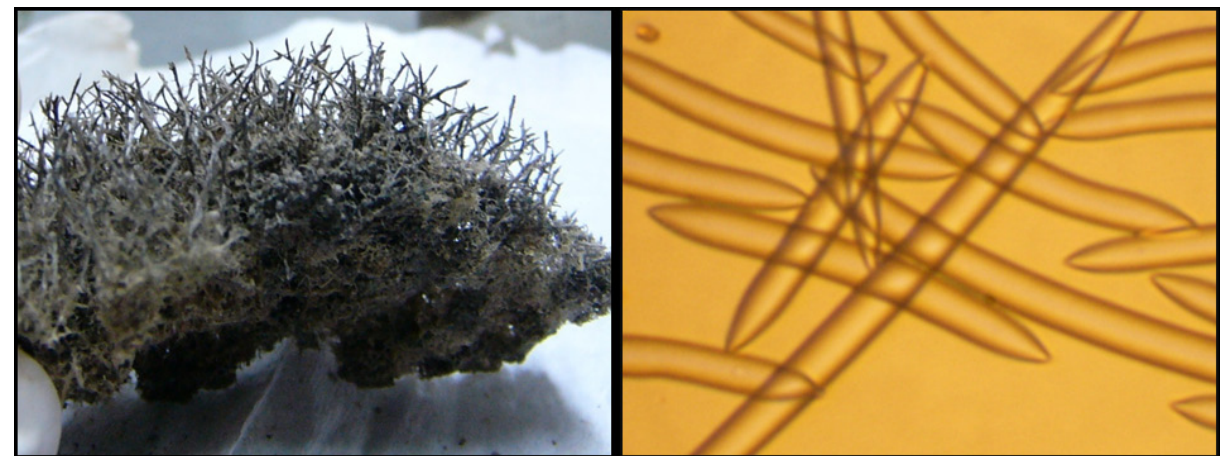
Figure 1. The freshwater sponge Drulia uruguayensis , showing its tree-like morphology, and some of its isolated